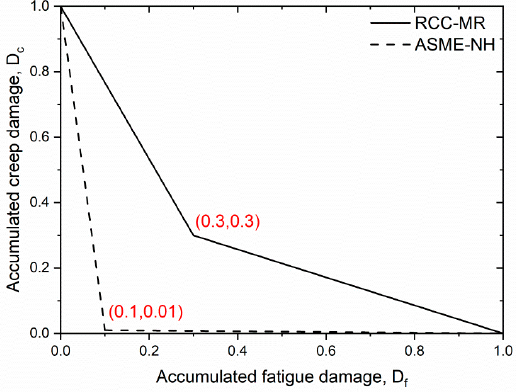
Figure 2. Damage interaction diagram of P91 steel in time fraction method.